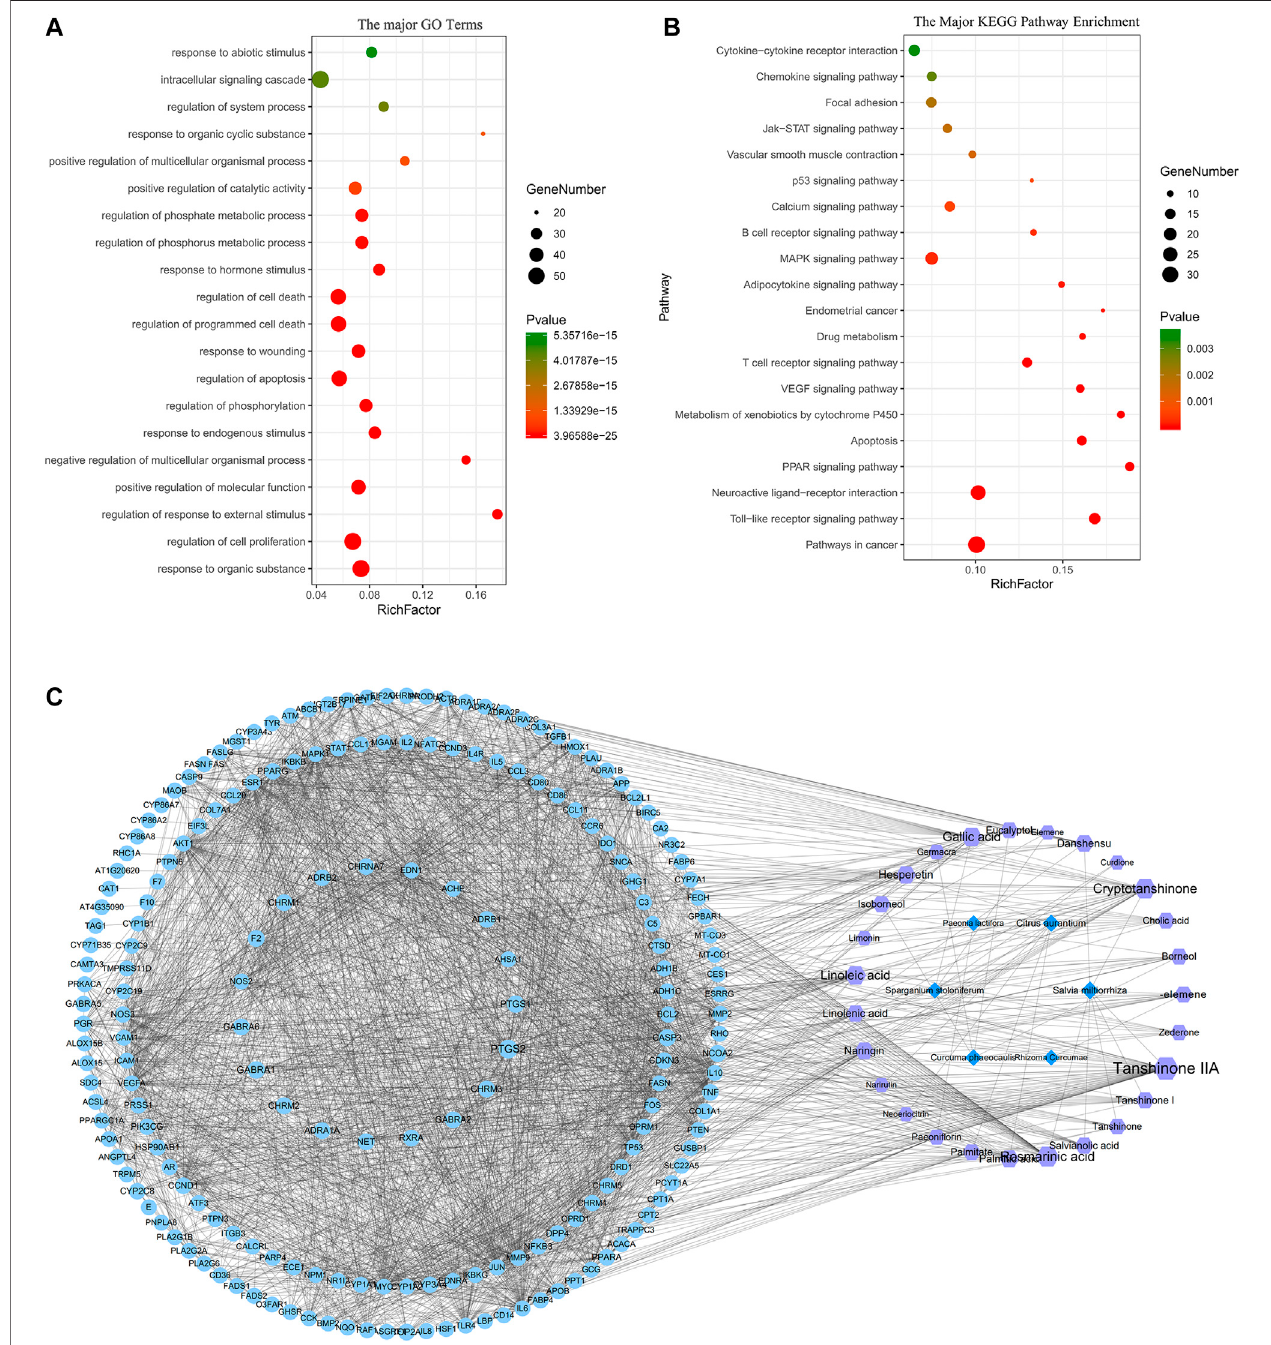
FIGURE 2 | Network pharmacology analysis of ELeng Capsule. (A) The major GO terms of BP of potential targets of ELC. (B) The 20 major KEGG pathways of potential targets of ELC. (C) “ Herb – compound – target-signaling pathway ” network of ELC. The light blue nodes represent targets (genes); the purple nodes represent compounds; the dark blue nodes represent